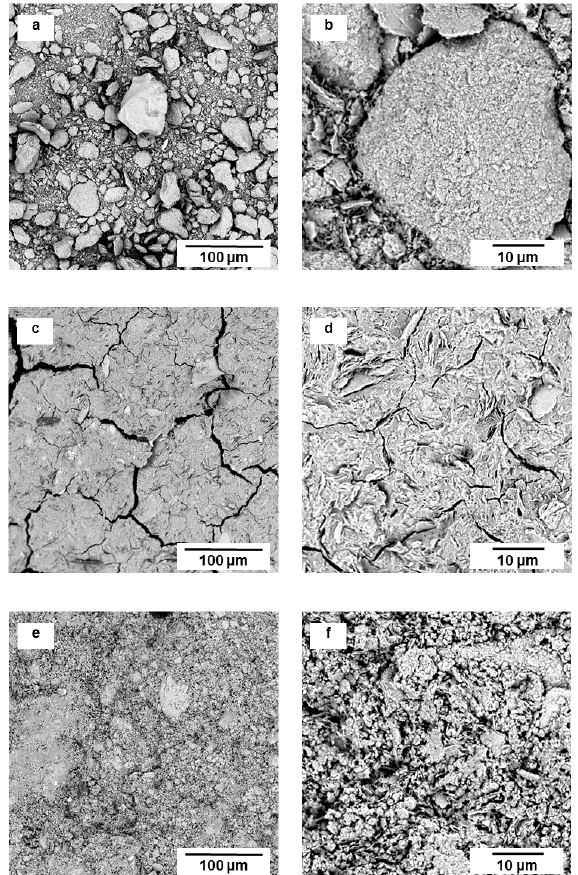
Figure 8. SEM micrographs of MKPC pastes (without sand) cross sections at different Al/P molar ratios: ( a ), ( b ) Al/P = 0.44; ( c ), ( d ) Al/P = 0.94; ( e ), ( f ) Al/P = 2.50. (Cured at room temperature, 28 days after synthesis)